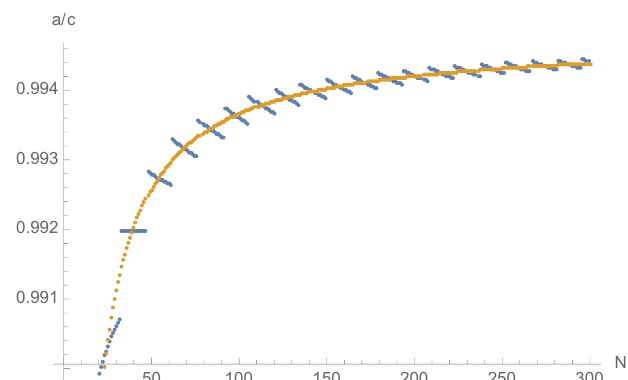
Figure 1 . Plot of a/c vs N . The blue dots represent the data and the orange curve fits the plot with a/c ’ − 0 . 1085 /N + 0 . 9947 .